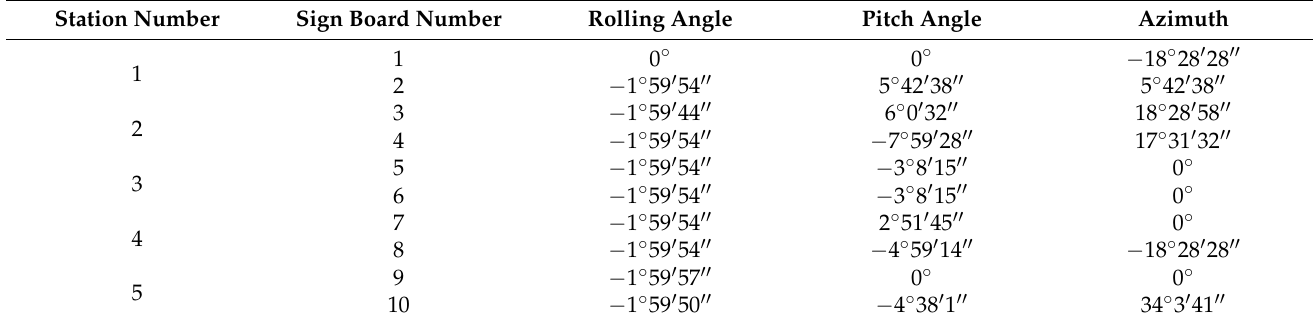
Table 1. Information on the pose of scraper conveyor in each station.